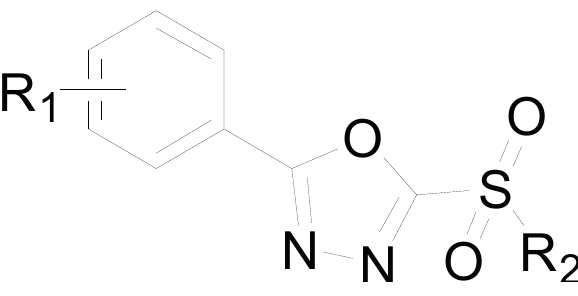
Figure 1. Compounds previously reported against tobacco and tomato bacterial